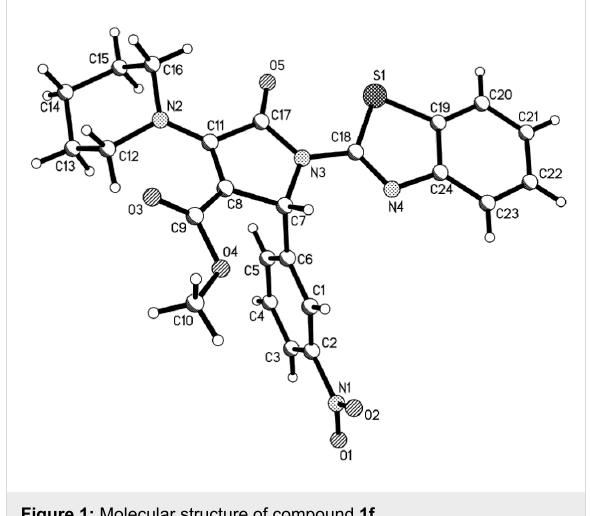
Figure 1: Molecular structure of compound 1f